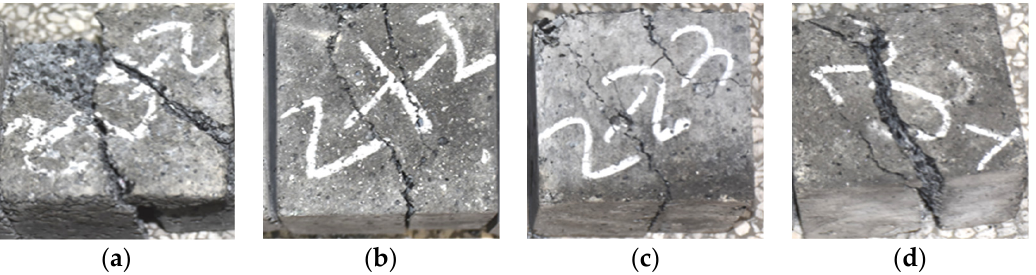
Figure 8. Effect of grouting pipes number on shear failure: ( a ) no grouting pipe; ( b ) one grouting pipe; ( c ) two grouting pipes; ( d ) three grouting pipes.